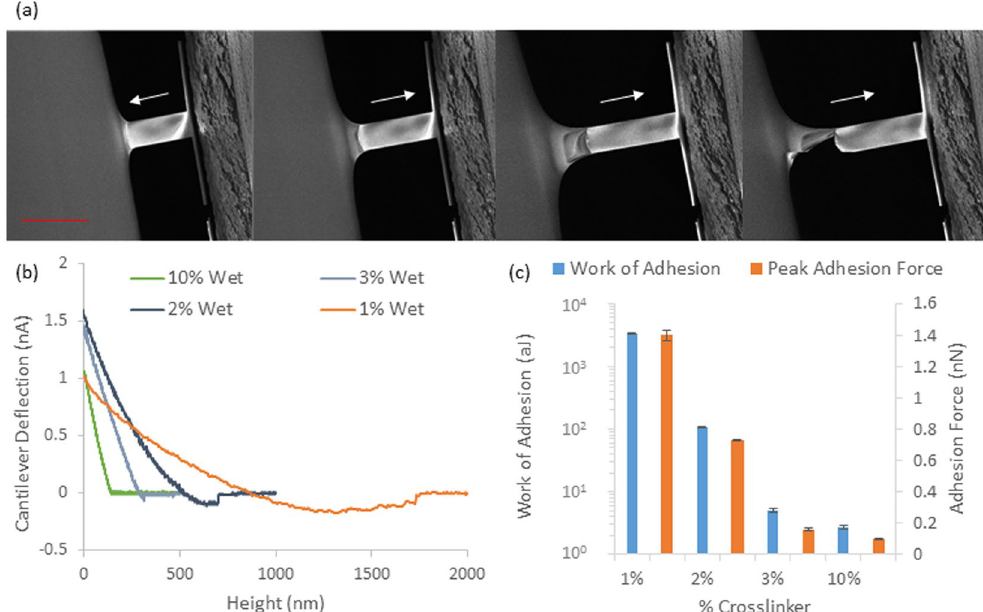
Figure 4. ( a ) SEM images of AFM tip interaction with 2% PDMS highlighting the adhesion between PDMS and Silicon Nitride AFM Tip snapping into and coming out of contact as indicated by the arrow. Scale bar is 100 um and ( b ) Nanoindentation by AFM retraction (lift) curves for PDMS samples tested wet in ethanol solution. All AFM experiments were conducted with an indentation depth of between 500 and 1000 nm and each curve was done over 1 s, each sample was tested in three different locations and 3 samples tested per formulation giving 900 data points per formulation ( c ) the average adhesion strength and peak adhesive force obtained by wet